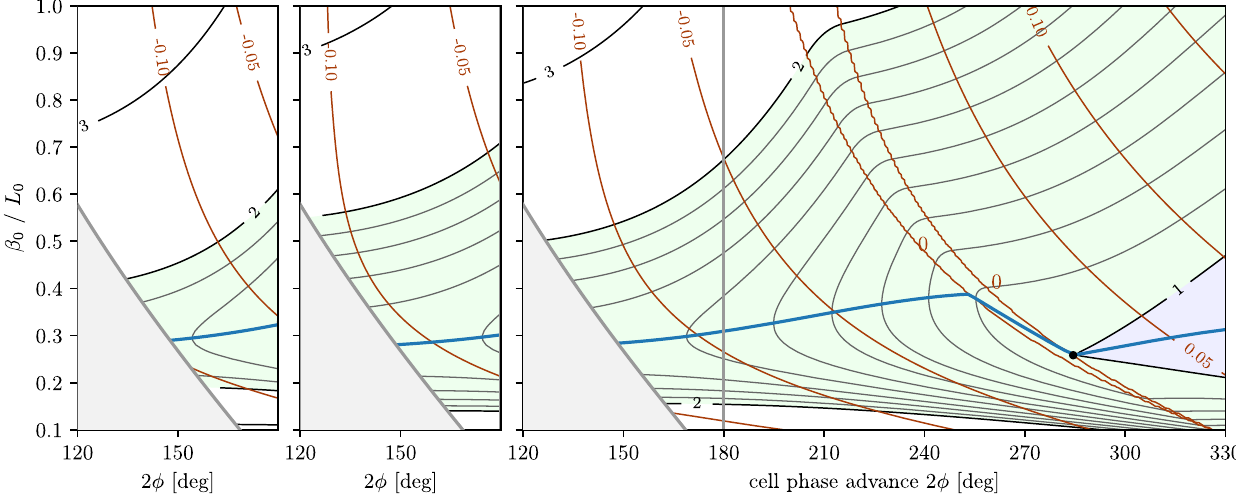
FIG. 13. Emittance ratio F for RB cells (see legend in Fig. 3) with different values of β 1 at the reverse-bend center. From left to right: β 20 L β 40 L β 30 L θ = θ 1 ¼ 0 , 1 ¼ 0 , 1 ¼ 0 . Red lines show 1 0 for the respective cells in steps of 0.05. At large phase advances, two isolines for θ 1 ¼ 0 (actually (cid:2) 10 − 4 ) delimitate a “ plateau ” of vanishing reverse bending angle, the black dot marking the TME condition